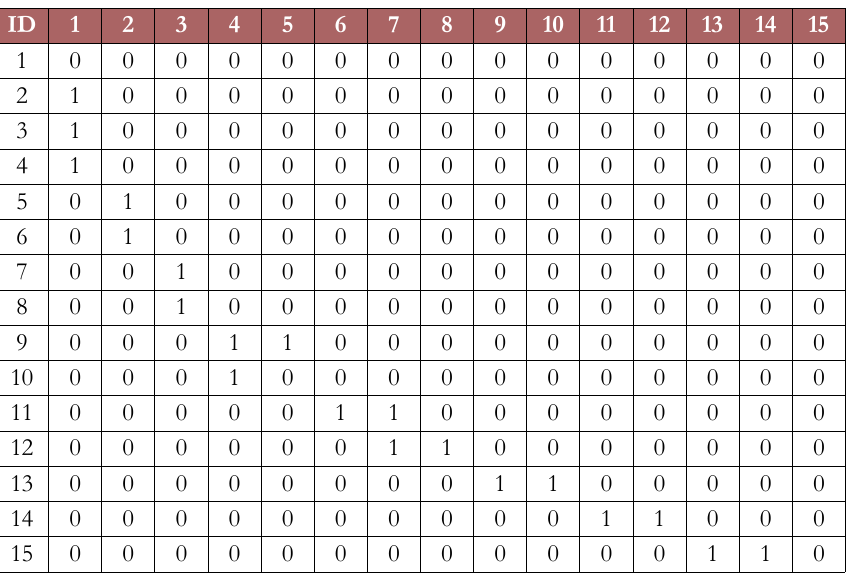
Table 1. Priority Matirx for experiment number 1